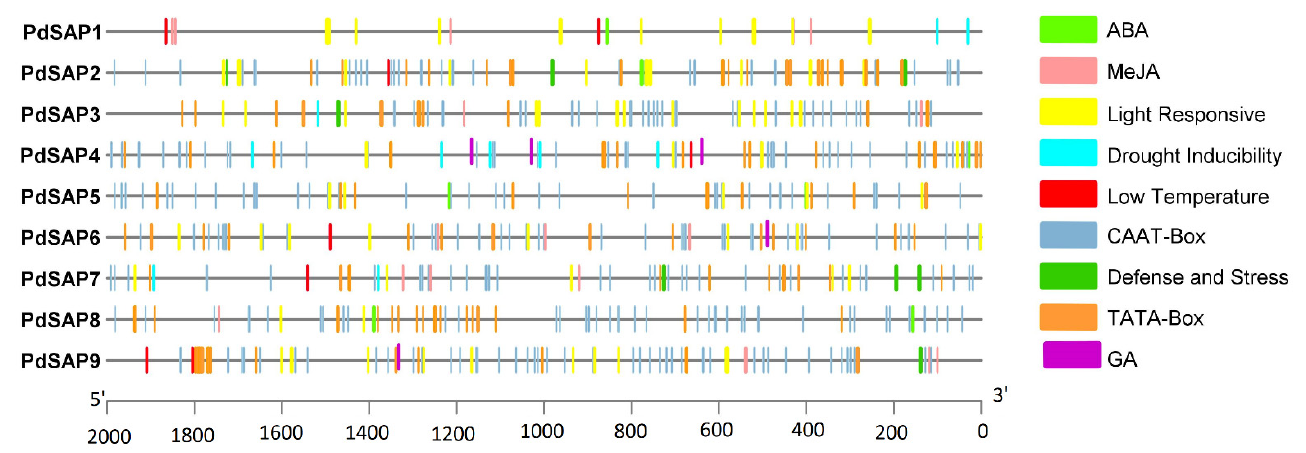
Figure 4. PdSAP cis -acting regulatory elements. Upstream promoter regions of PdSAP contained the cis -acting regulatory elements, and these are shown in various colors in the figure, with the length of the upstream region of PdSAP genes indicated on the x